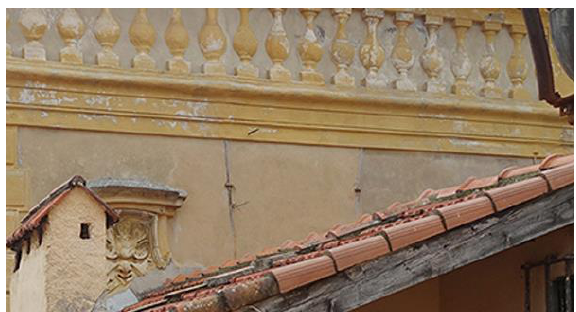
Figure 5. External view of the Family Portrait Room, 2018